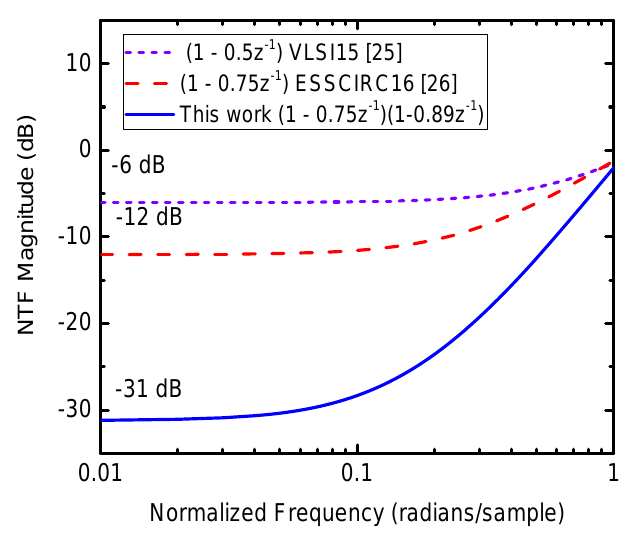
Figure 9. Different noise transfer function (NTF) performance versus normalized frequency.